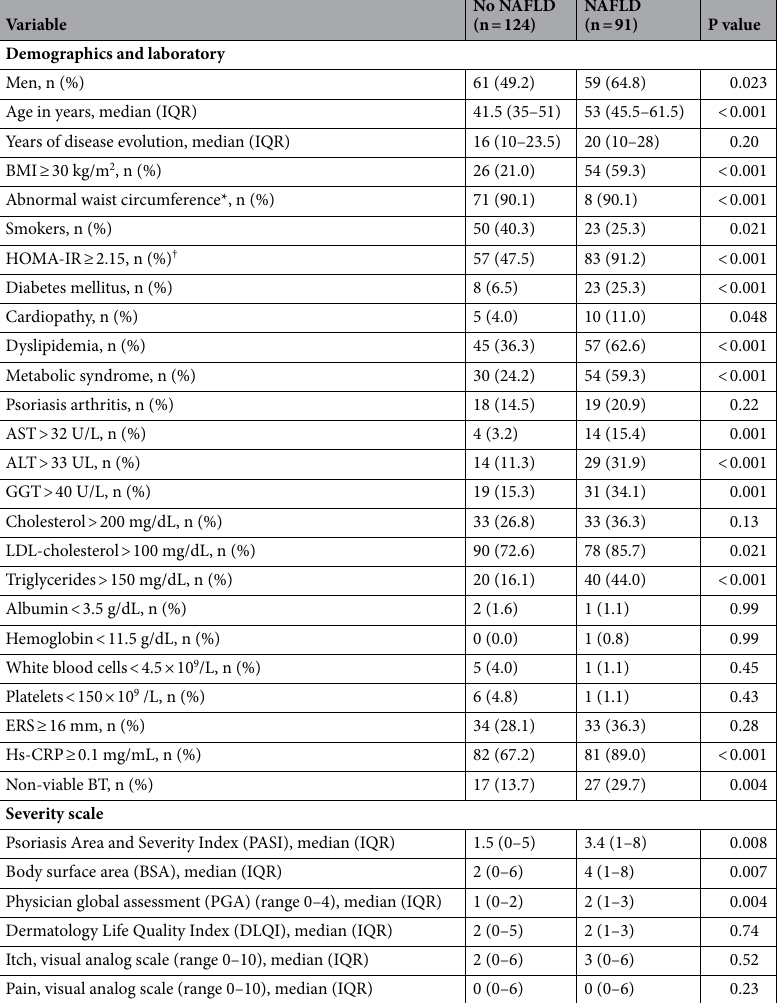
Table 1. Demographic, clinical, and laboratory characteristics of psoriatic patients with and without non- alcoholic fatty liver disease (NAFLD). AST aspartate aminotransferase, ALT alanine aminotransferase, BMI body mass index, BT bacterial translocation, ERS erythrocyte sedimentation rate, GGT g-glutamyl transferase, IQR interquartile range, hs-CPR high-sensitivity C-reactive-protein, HOMA-IR homeostatic model assessment of insulin resistance, LDL low-density lipoprotein. *Abnormal waist circumference: women, ≥ 86 cm, ≥ 95 cm male. † HOMA-IR available in 211